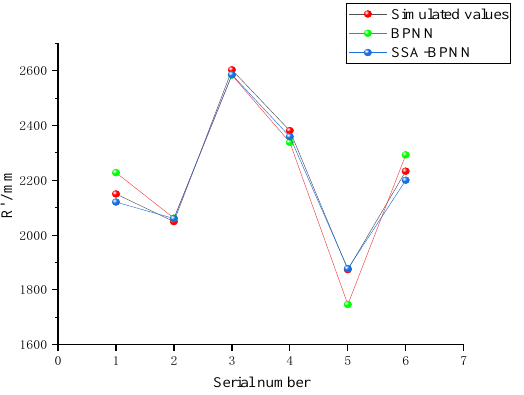
Figure 13. Comparison diagram of prediction results of springback radius.